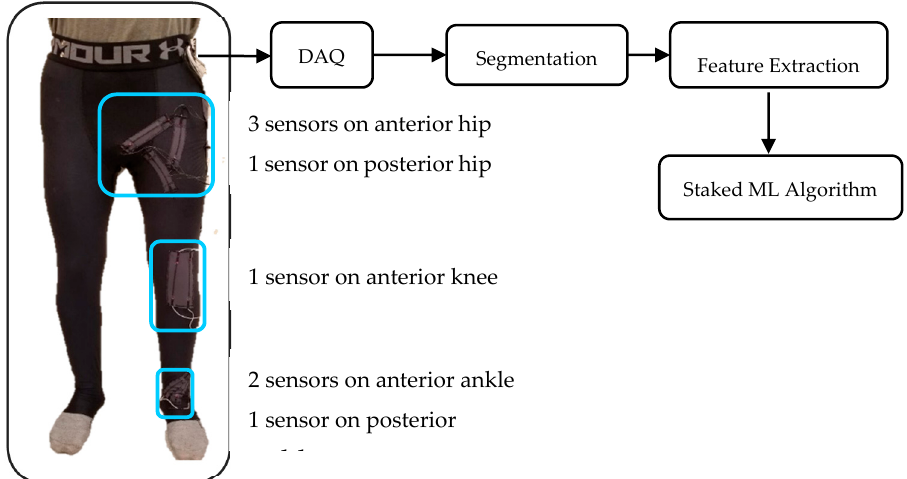
Figure 1. Strain sensor positions on a pair of running tights and the data processing schematic. DAQ, data acquisition device; ML, machine learning.